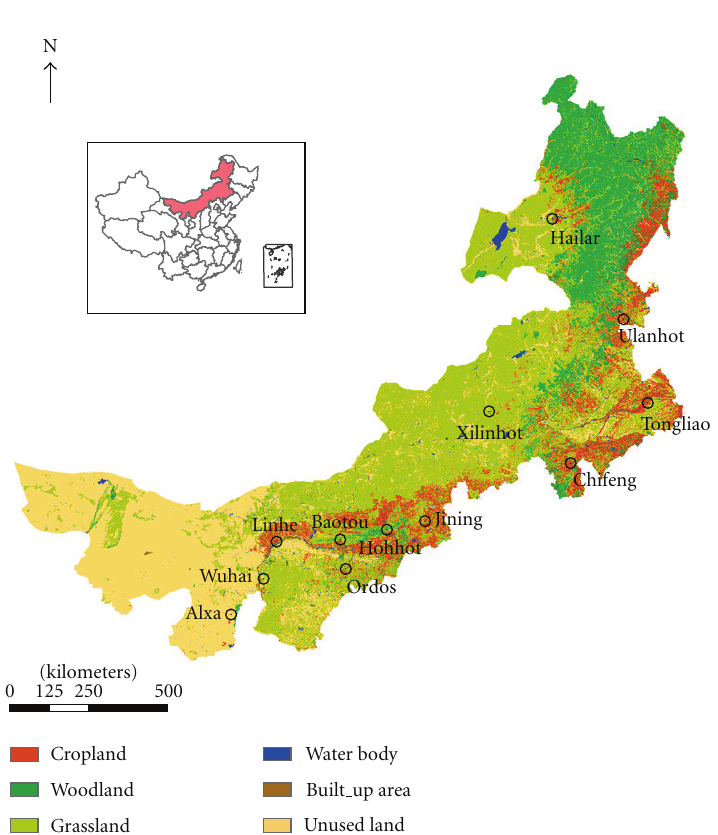
Figure 1: Study area and its land use in 2000 based on TM/ETM+